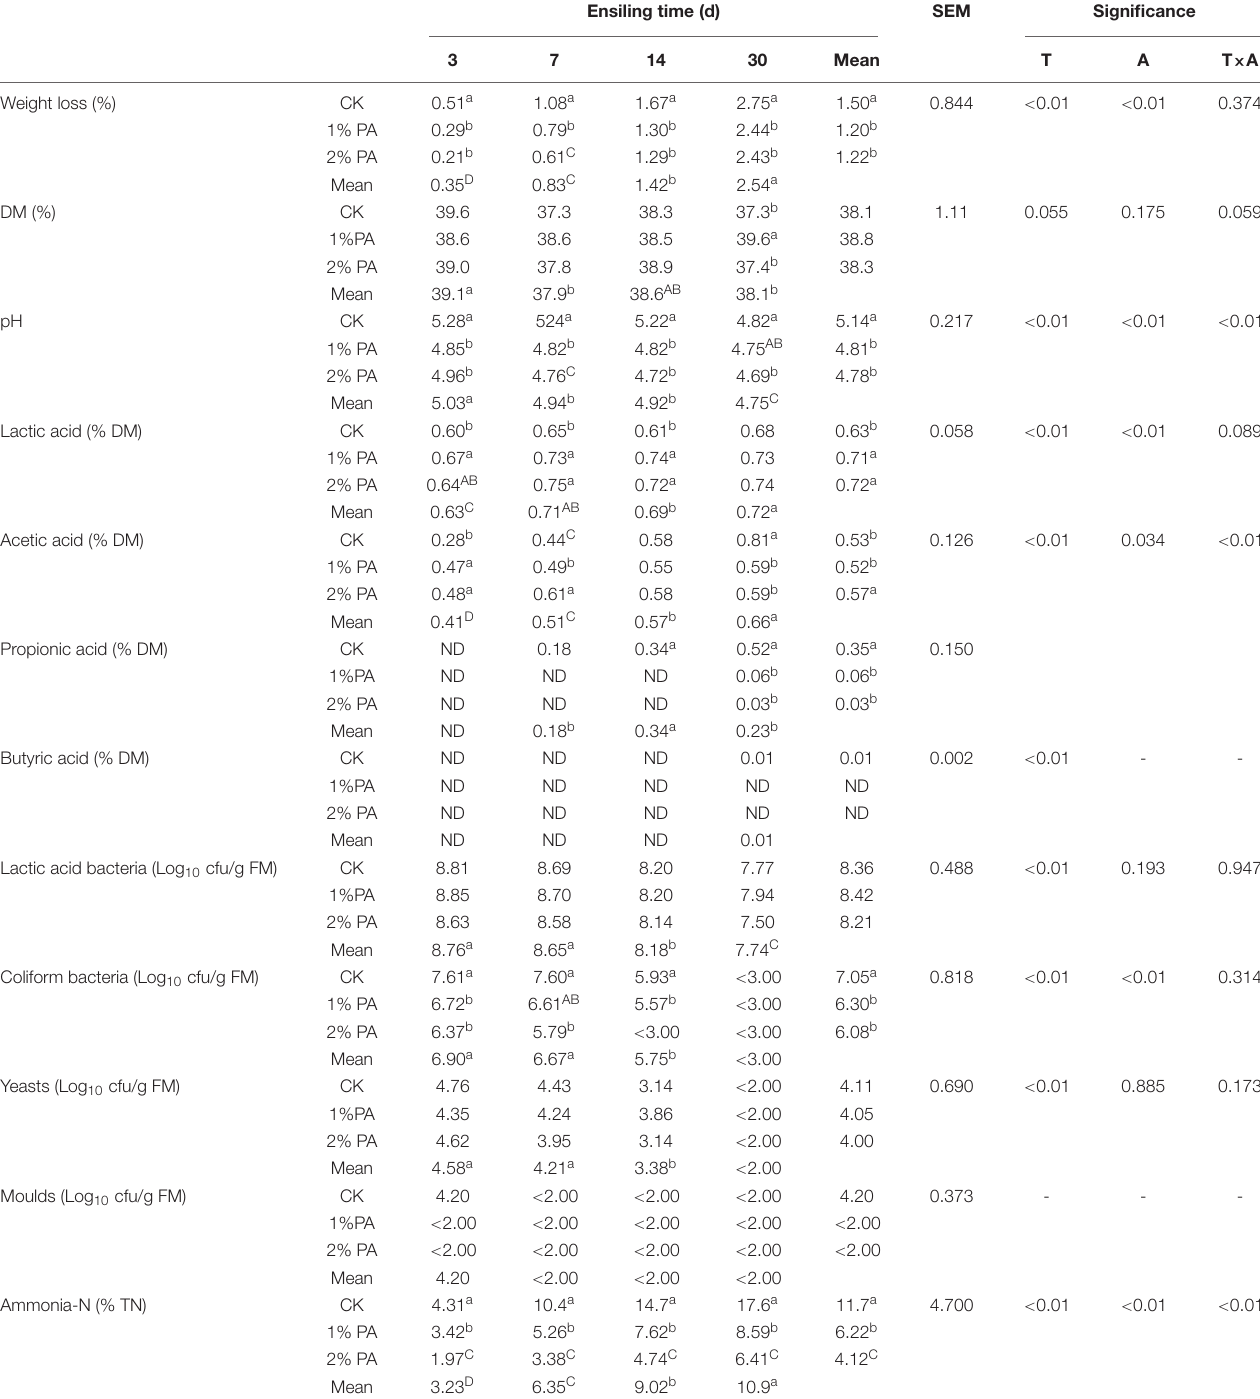
Ensiling time (d)